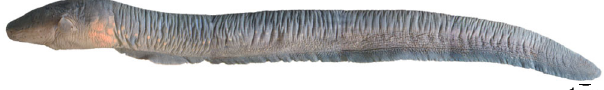
Fig. 6 Lateral view of Electrophorus varii sp. nov. Holotype, Museu